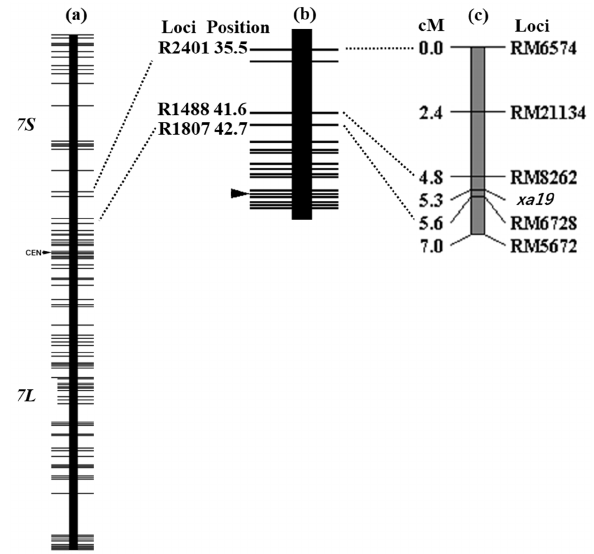
Figure 2. Linkage map of xa19 and surrounding DNA markers. ( a , b ) RFLP framework maps of chromosome 7 modified from Harushima et al. [47]. ( c ) the linkage map of xa19 gene constructed from F 2 population from the cross between XM5 and IAS44 ( n = 210). DNA markers located near each other on Os-Nipponbare-Reference-IRGSP-1.0 are connected by dotted lines. Table 5. Genotypes of informative recombinants for the DNA marker loci linked with xa19 on chro- mosome 7 in the F 2 population (XM5 × IAS44), and the gene segregation in the F 3 generation. 1 X, H and A, respectively, denote homozygotes for XM5, heterozygotes, homozygotes for IAS44. 2 R and S, respectively, denote resistant and susceptible to Xoo race II and the gene segregation in the F 3 generation. 3 - indicates that F 3 progeny were not tested for Xoo resistance. Genotypes of the Segregation DNA marker loci 1 in F 3 plants 2